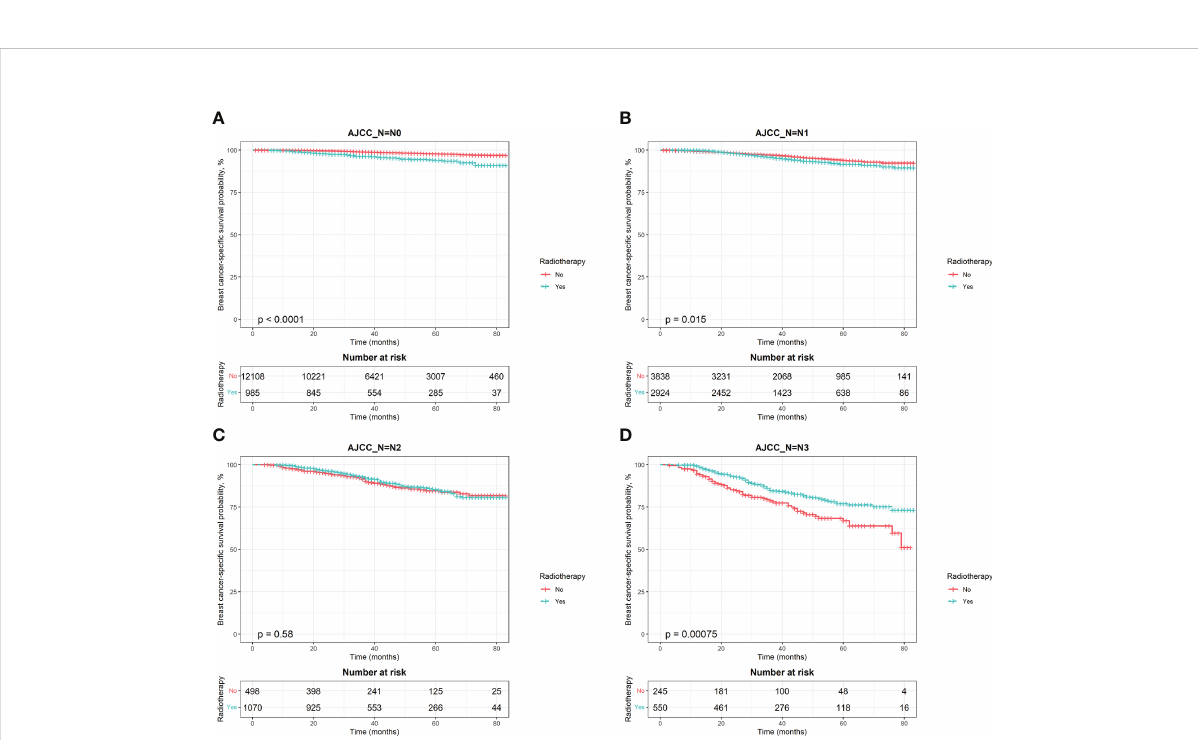
FIGURE 5 Kaplan – Meier survival curves of breast cancer-speci fi c survival after stratifying by AJCC N stage. (A) , AJCC_N=N0; (B) , AJCC_N=N1; (C) , AJCC_N=N2; (D) ,